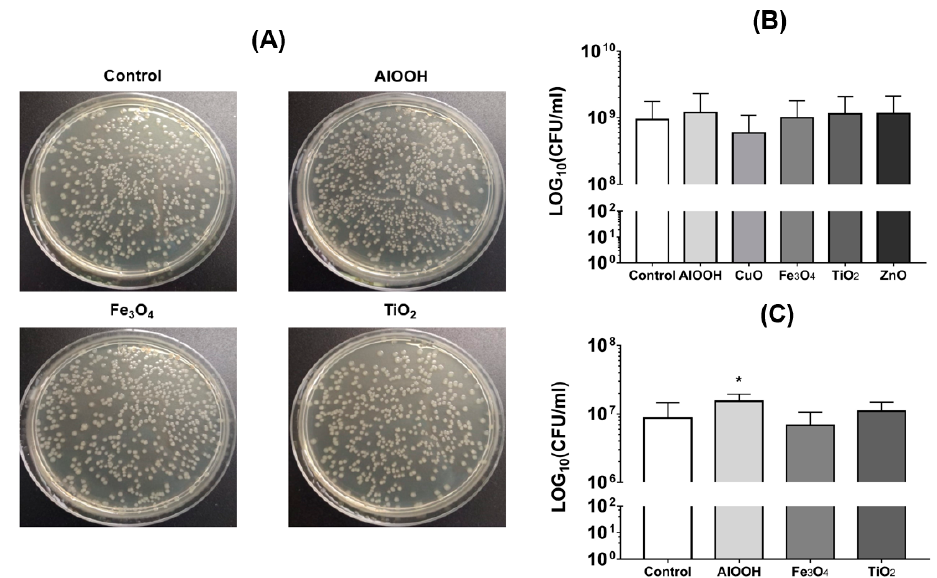
Figure 3. Effect of MONPs on conjugation. ( A ) Images of bacteria CFU of transconjugants on LB-agar plates with streptomycin (100 µ g / mL) and tetracycline (12.5 µ g / mL) after conjugation in MONPs presence (500 µ g / mL). ( B , C ) Statistical analysis of the CFU number after conjugation in the presence of MONPs in concentration ( B ) 50 µ g / mL, ( C ) 500 µ g / mL. The presented results are the mean of three independent experiments (three replicates in each) ± standard deviation. * p < 0.05.